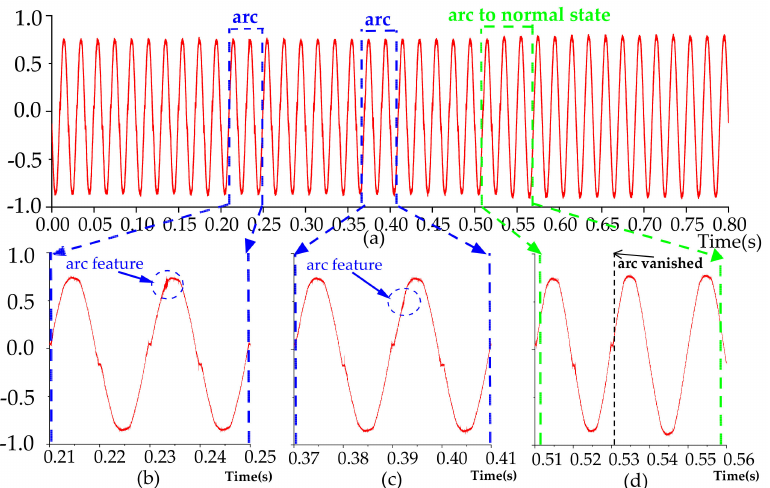
Figure 3. Heater load’s current. ( a ) From arc state to normal state; ( b ) Arc feature; ( c ) arc feature; ( d ) arc vanished